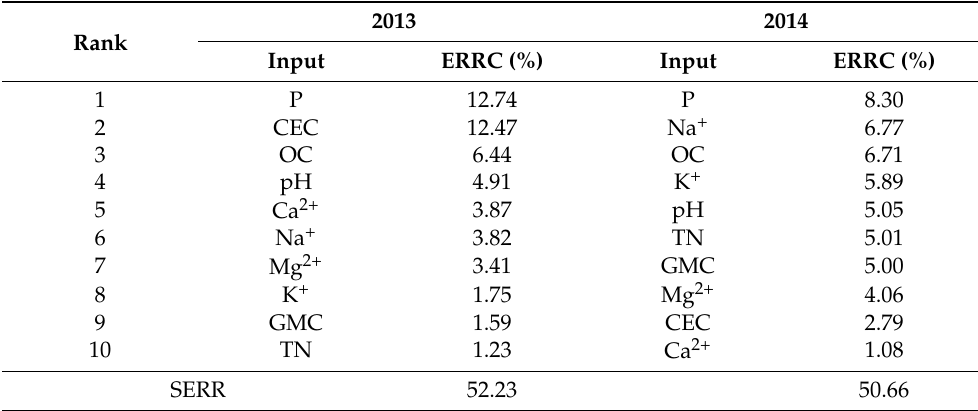
Table 5. Calculated individual contribution (ERRC) of each soil property and the sum of contribution (SERR) to crop yield in the 2013 and 2014 cropping seasons, obtained with the non-linear finite impulse response (NFIR) model, accounting for both linear and non-linear relationships (NFIR-LN).